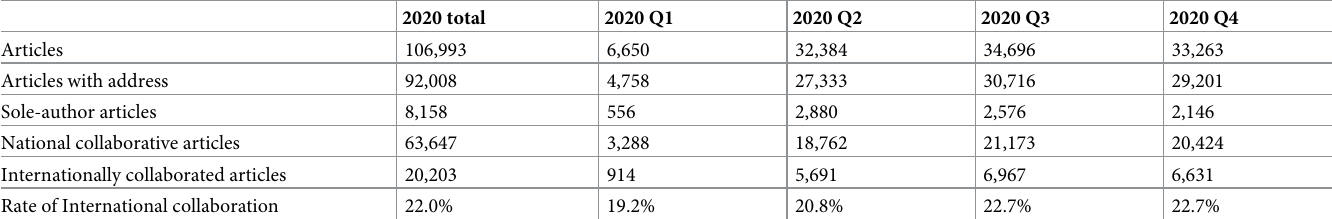
Table 1. Number of coronavirus publications in